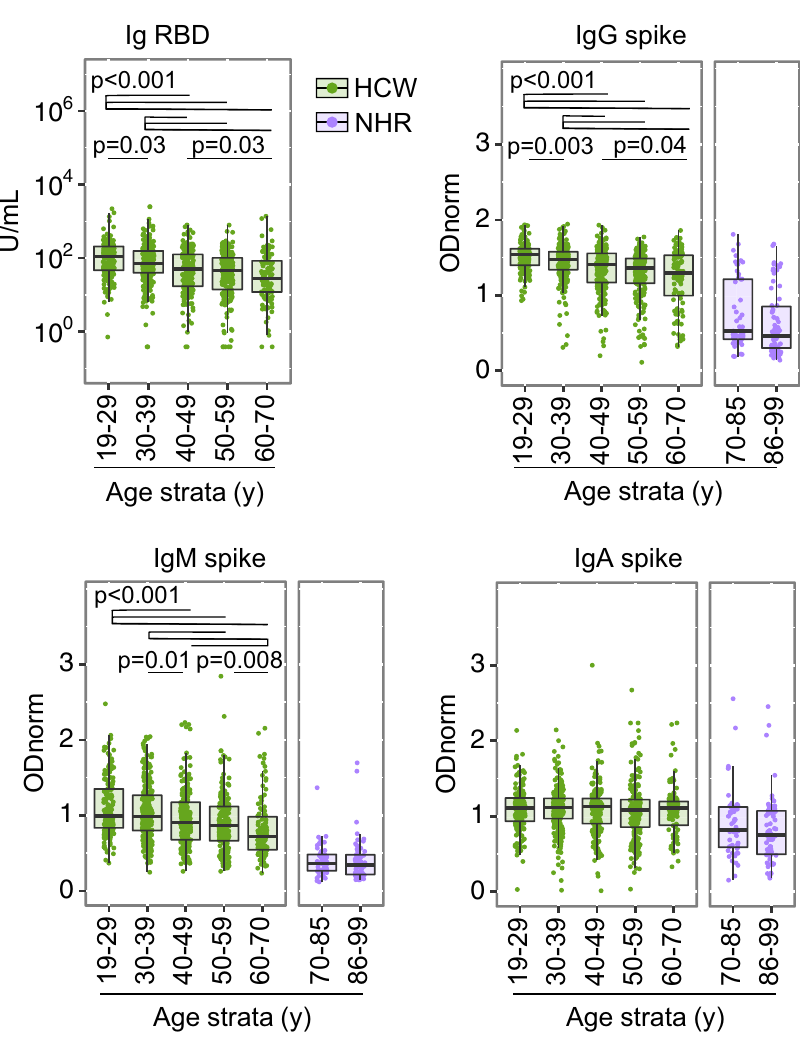
Fig. 3 Cumulative effect of age on anti-SARS-CoV-2-spike reactivities induced by vaccination. Shown are semi-quantitative measurements in the Health Care Workers (HCW) n = 948, in green, and Nursing Home Residents (NHR) n = 118, in purple, cohorts at t1, as in Fig. 2B, now strati fi ed by age group in 10 points represent individual participants, boxes denote interquartile range, horizontal lines represent the median, and whiskers denote the minimum and maximum values below or above the median at 1.5 times the interquartile range. Kruskal – Wallis test for group difference across HCW age groups, p = 1.875× 10 − 15 for anti-RBD Ig, p < 2.2× 10 − 16 for anti-spike IgG, p = 4.385× 10 − 13 for anti-spike IgM, p = 0.55 for anti-spike IgA. Signi fi cant p